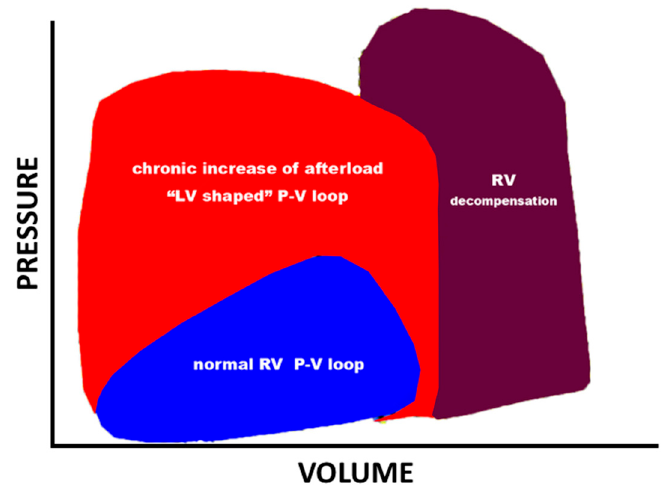
Figure 1. Right ventricular (RV) pressure-volume (P-V) loops obtained by a catheterism. The blue loop depicts a normal RV P-V loop. The red loop represents a compensated, chronically hypertensive RV (left ventricle, LV-shaped loop). The violet loop represents a decompensated RV.